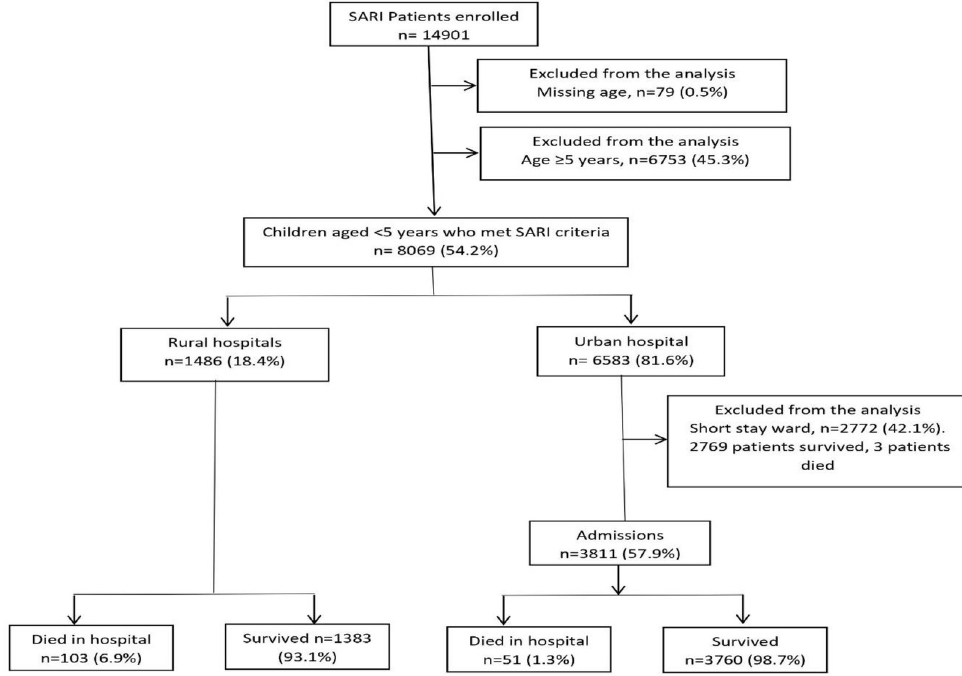
Fig 1. Flow chart of children enrolled in the South African severe acute respiratory illness (SARI) surveillance program at urban and rural hospitals in South Africa, 2009 to 2013.